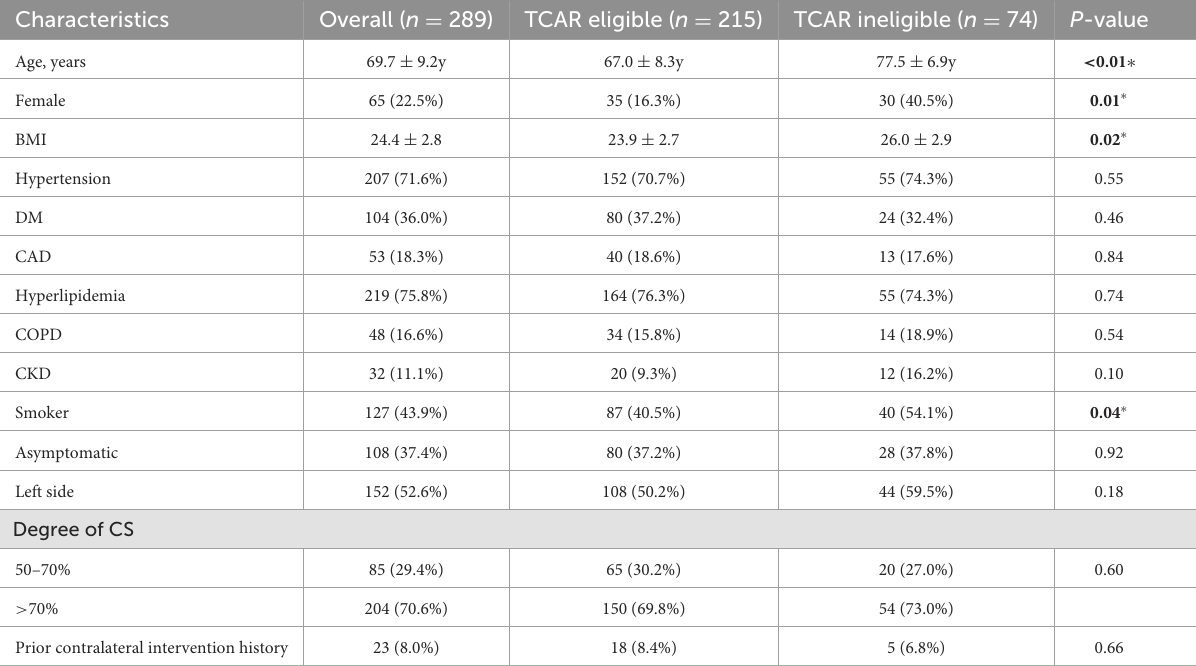
TABLE 1 Baseline characteristics of patients who were eligible or not eligible for TCAR.